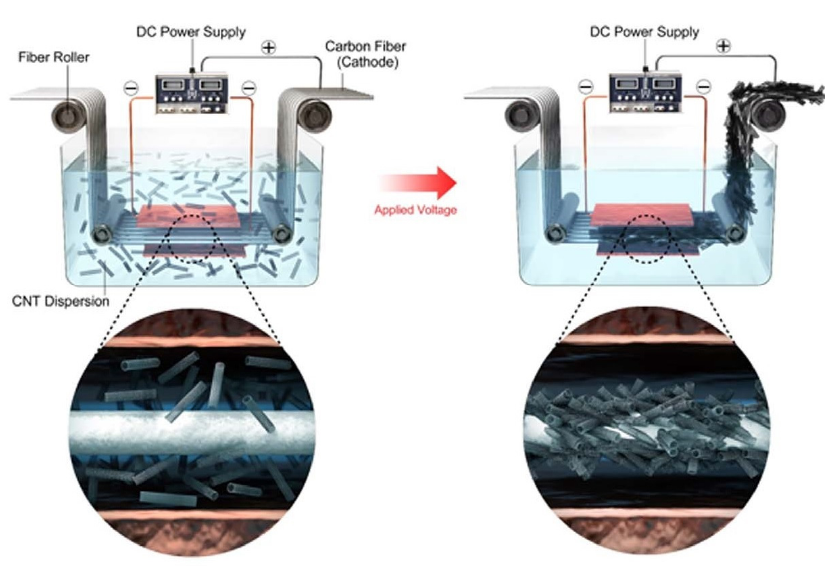
Figure 2. Experimental set-up for CNT deposition on CF using EPD (reprinted with permission) [13]. Wu et al. [9] fabricated MWCNT/polyimide (PI) composite films through electrophoretic deposition of carboxylated-MWCNTs and poly (pyromellitic dianhydride-co-4,40-oxydianiline) (PMDA-ODA). These negatively charged MWCNTs, and PMDA-ODA were deposited on a positive anode electrode under an electric field and formed MWCNT/PI composite film. The presence of MWCNTs in the PI matrix decreased the surface resistivity by approxi- mately 100% and increased the tensile strength and modulus by 14% and 50%,